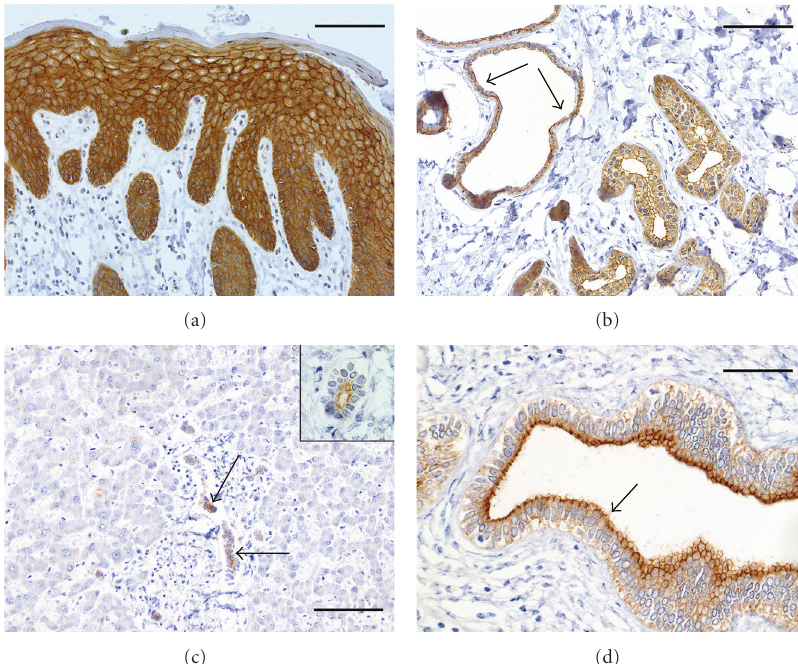
Figure 4: Immunohistochemical staining of sections of human skin a, and b and liver c, and d with antibodies against PKP 3. (a) Intensive reaction of desmosomes and cytoplasm is visible by staining sections of human skin with a monoclonal antibody against PKP 3 (clone PKP3 310.9.1; Progen, Heidelberg). Basal and lower suprabasal keratinocytes exhibit a strong cytoplasmic staining while desmosomal staining is less prominent. With ongoing di ff erentiation, the desmosomal labeling is increasing. (b) Eccrine and apocrine (arrows) sweat glands show strong desmosomal labeling with PKP 3-specific antibodies. (c) Reaction of PKP 3-specific antibodies on liver is restricted to bile ductules (arrow; see description of liver tissue in the legend to Figure 3) while hepatocytes are completely negative for PKP 3. The insert presents a magnification of a bile ductule of human liver stained with antibodies against PKP 3, exhibiting a labeling of the desmosomal junctions. (d) Bile ducts (here in a large portal field) show a clear desmosomal reaction at the apical pole of cells (arrow). Scale bars: 100 μ m (d), 200 μ m a, b,